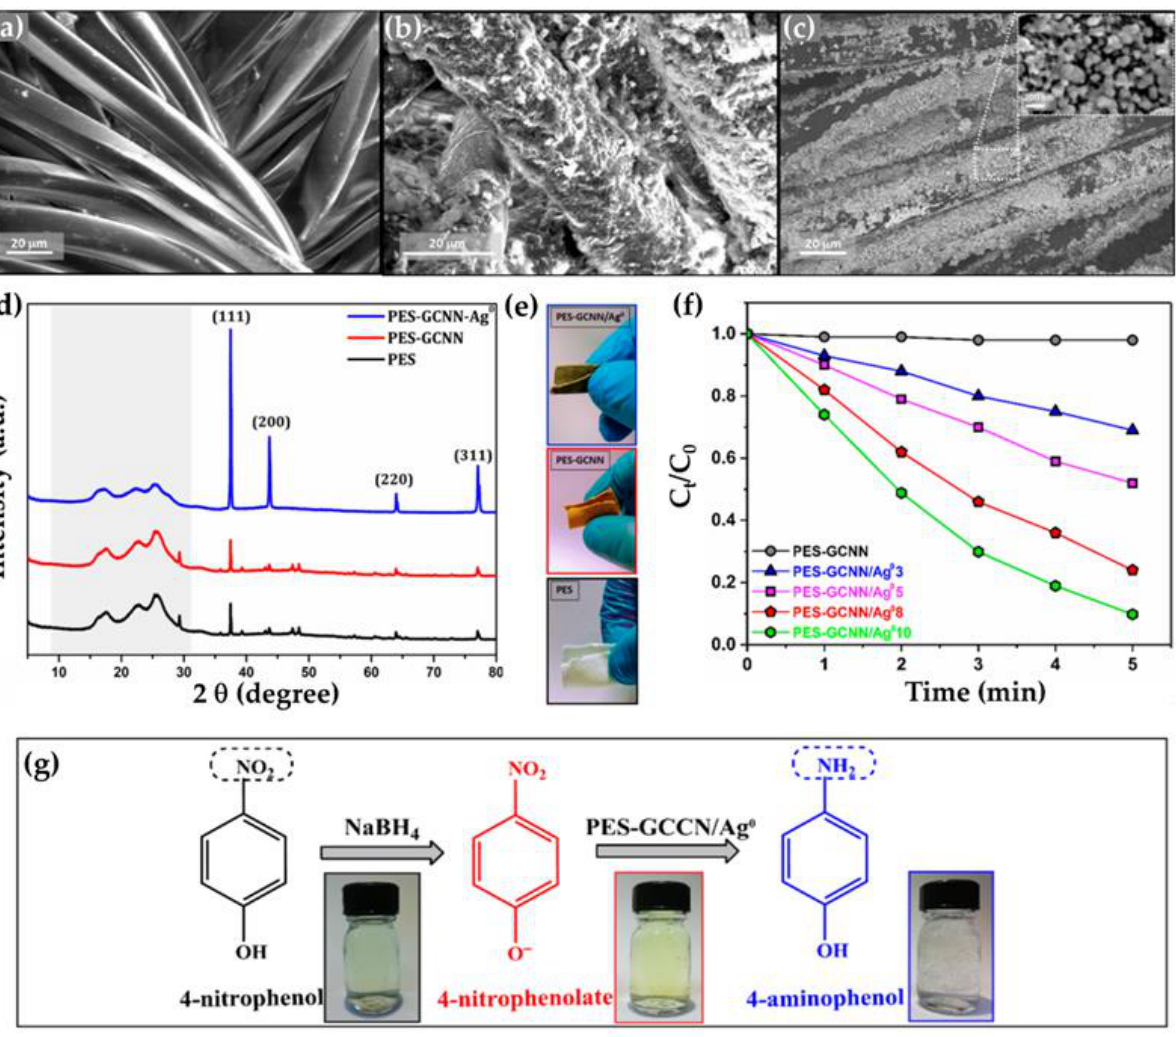
Figure 3. SEM images of uncoated PES fabric ( a ), PES coated with g-C 3 N 4 (PES-GCNN sample) ( b ), and PES coated with Ag/g-C 3 N 4 nanocomposite containing 10 wt% of Ag 0 (PES-GCNN-Ag 0 10) ( c ); XRD patterns of PES, PES-GCNN, and PES-GCNN-Ag 0 10 samples ( d ); photos of PES, PES-GCNN, and PES-GCNN-Ag 0 10 samples ( e ); time-dependent 4-NP conversion over PES-GCNN-Ag 0 samples containing 3, 5, 8, and 10 wt% of Ag 0 ( f ); reaction scheme and photographs representing reduction of 4-NP to 4-AP by NaBH 4 catalyzed by PES-GCNN-Ag 0 ( g ). Reprinted with permission from [79]. Copyright 2021, MDPI.